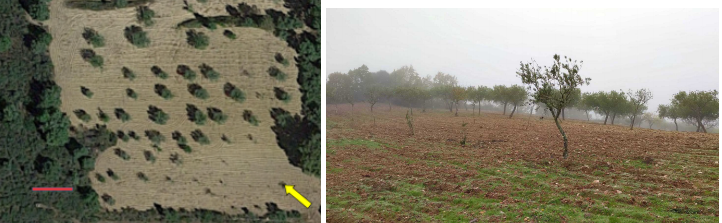
Figure 18. Local C: olive groove with known natural radiation. ( left ) Satellite view. ( right ) Ground- level